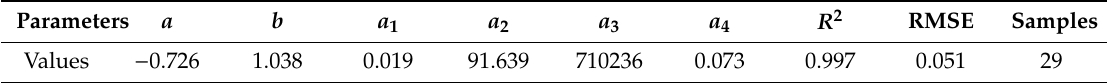
Figure 3. Variations of baseline stemwood growth with age for Larix gmelinii . Dots represent steemwood biomass growth calculated by yield tables; error bars represent standard deviation. Table 3. Coefficient estimates and goodness of fit statistics (Mg C/ha/yr) of Equations (3) and (4).